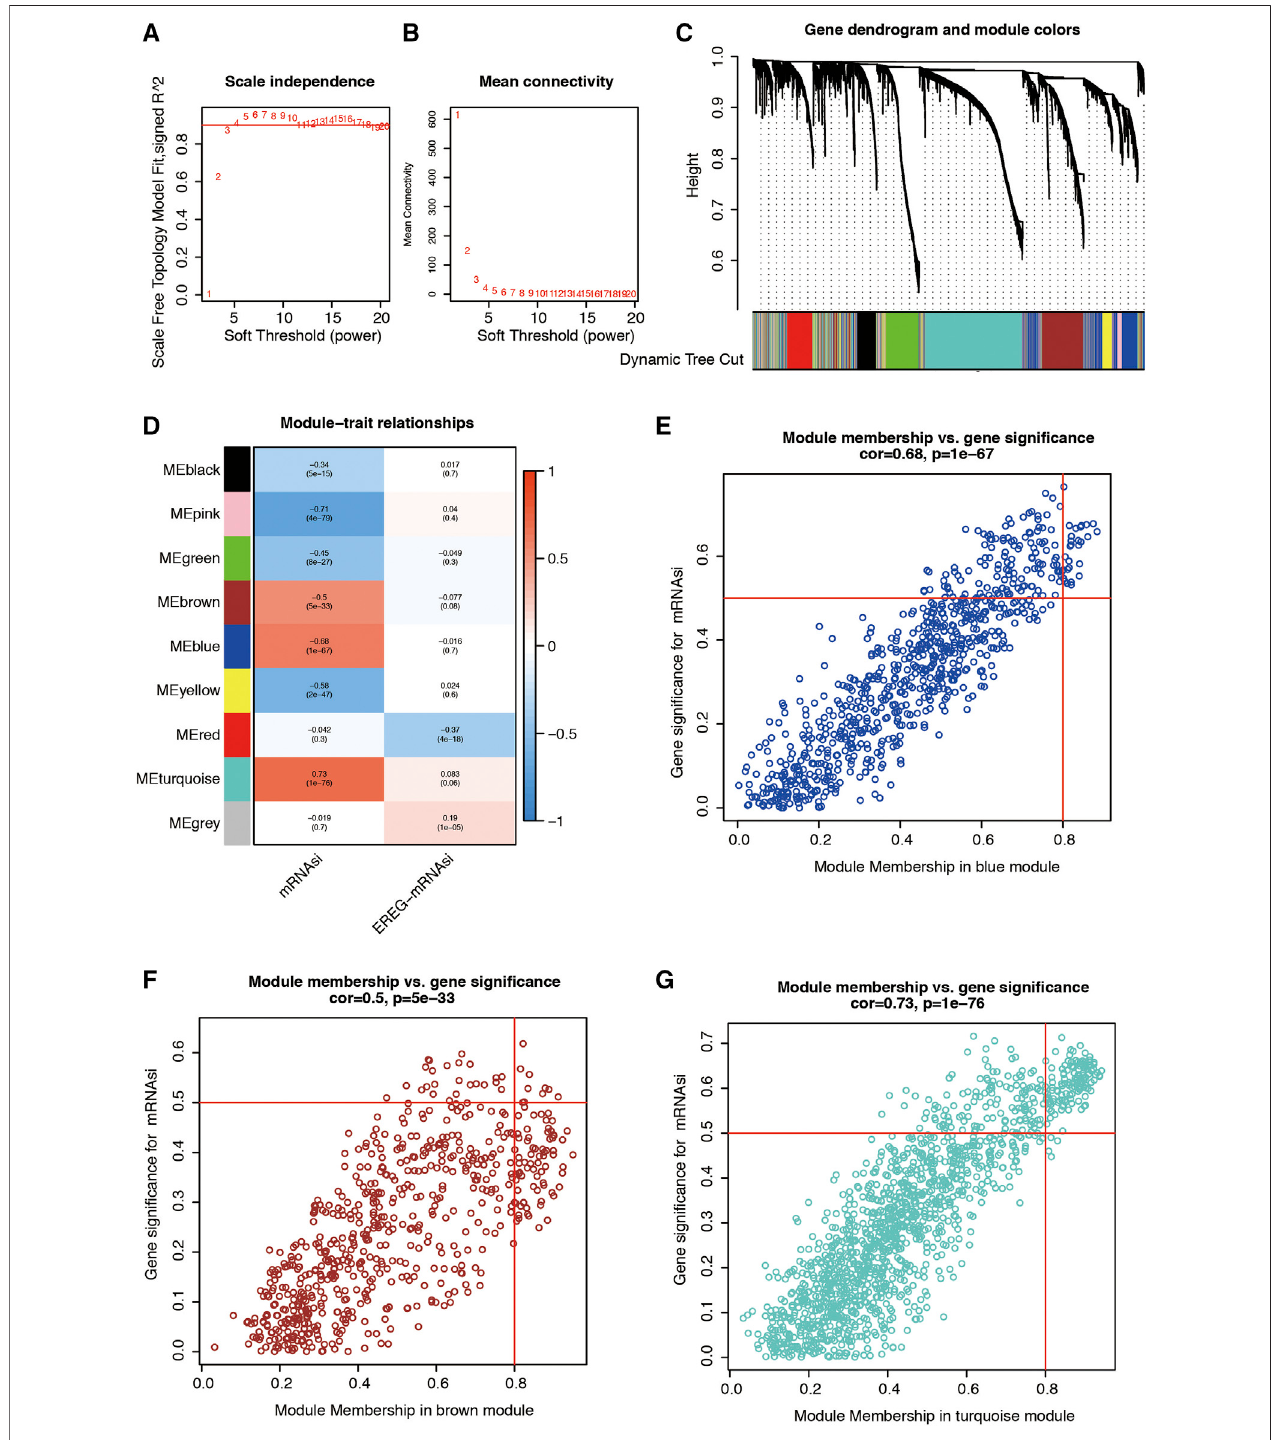
FIGURE2|(A,B) Graphsofscaleindependence,meanconnectivityandscale-freetopology,theappropriatesoft-powerwas4. (C) Clusterdendrogramoftheco- expression network modules (1-TOM). (D) Correlation between the gene module and clinical characteristics, including the mRNAsi and EREG-mRNAsi. (E) Scatter diagramforMMvs.GSforthemRNAsiinthebluemodule. (F) ScatterdiagramforMMvs.GSforthemRNAsiinthebrownmodule. (G) ScatterdiagramforMMvs.GSfor the mRNAsi in the turquoise module. LUAD, lung adenocarcinoma; mRNAsi, mRNA expression-based stemness index; EREG, epigenetically regulated.